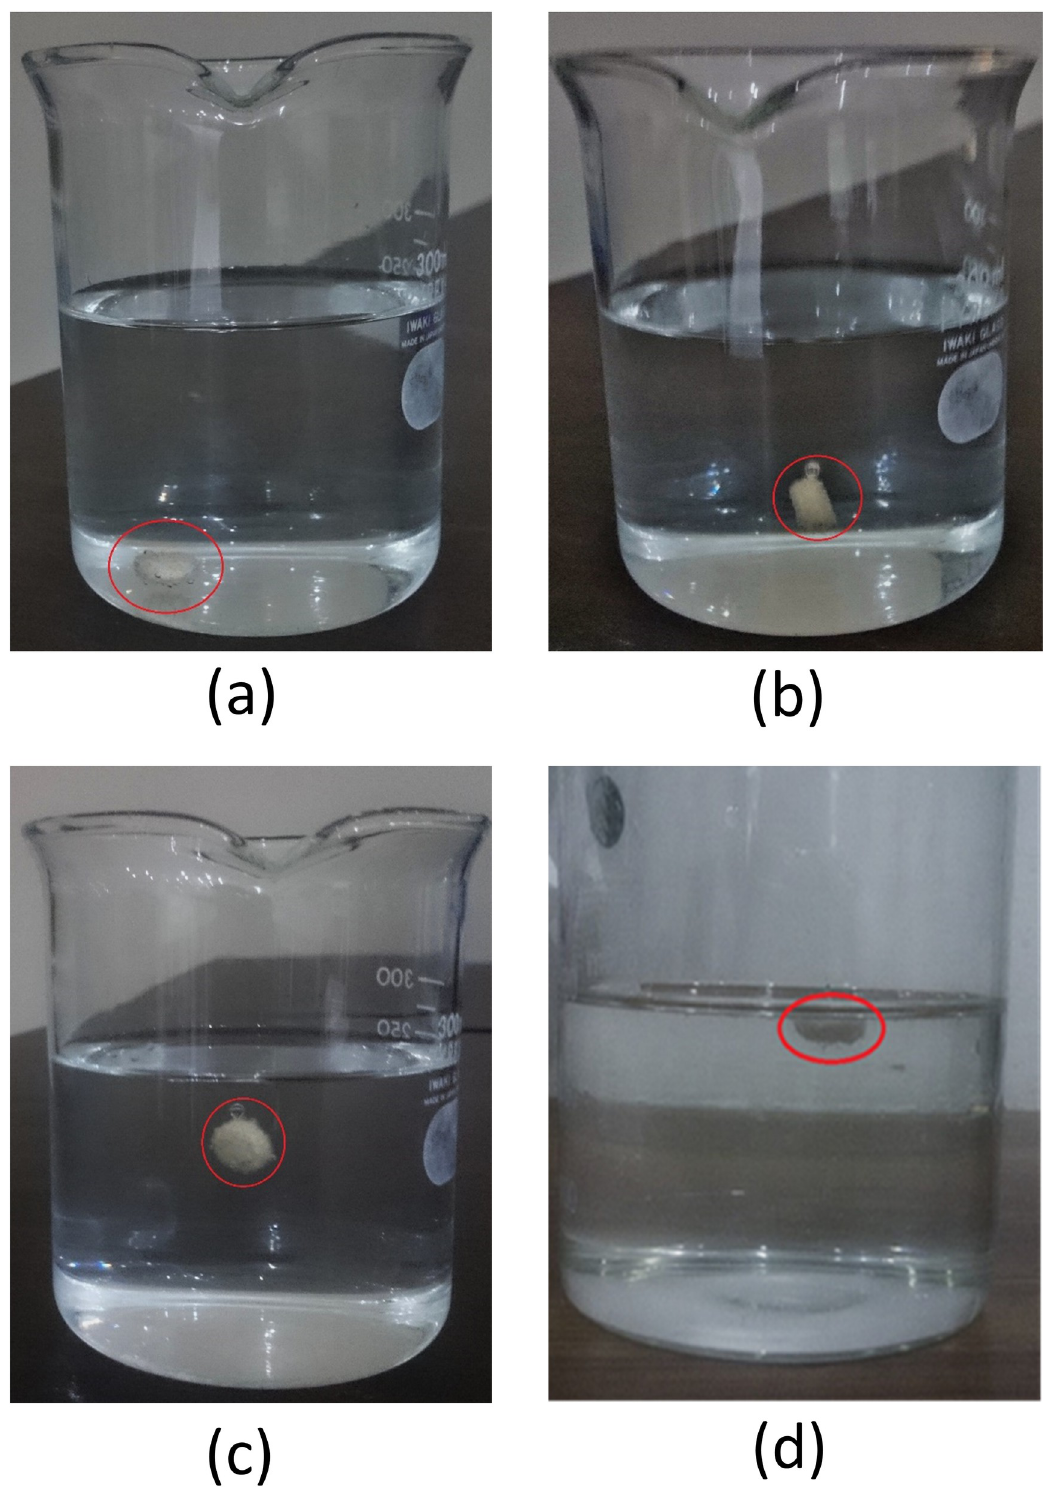
Fig 2. Invitro buoyancy studies of propranolol HCl (a) Propranolol HCl tablets behavior immediately after immersion to 0.1N HCl, (b) after a few seconds of immersion, (c) after one minute of immersion, (d) after 12 hours of immersion.